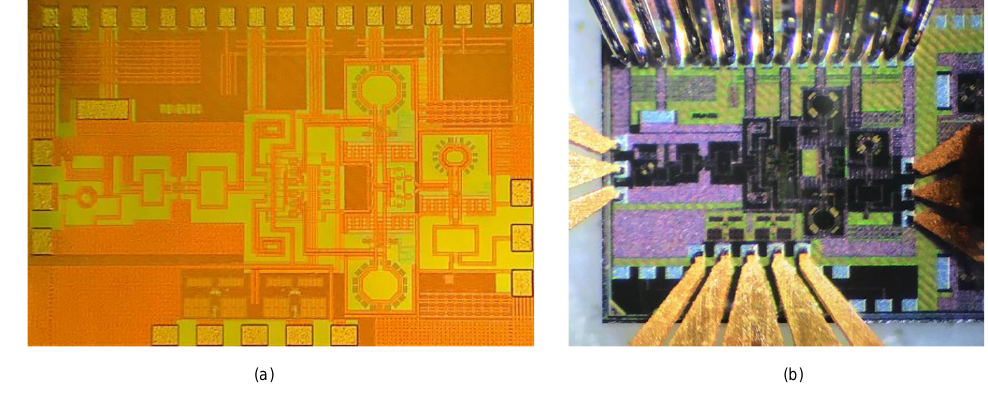
Figure 10. ( a ) Chip micrograph; ( b ) On-wafer probing measurement setup.